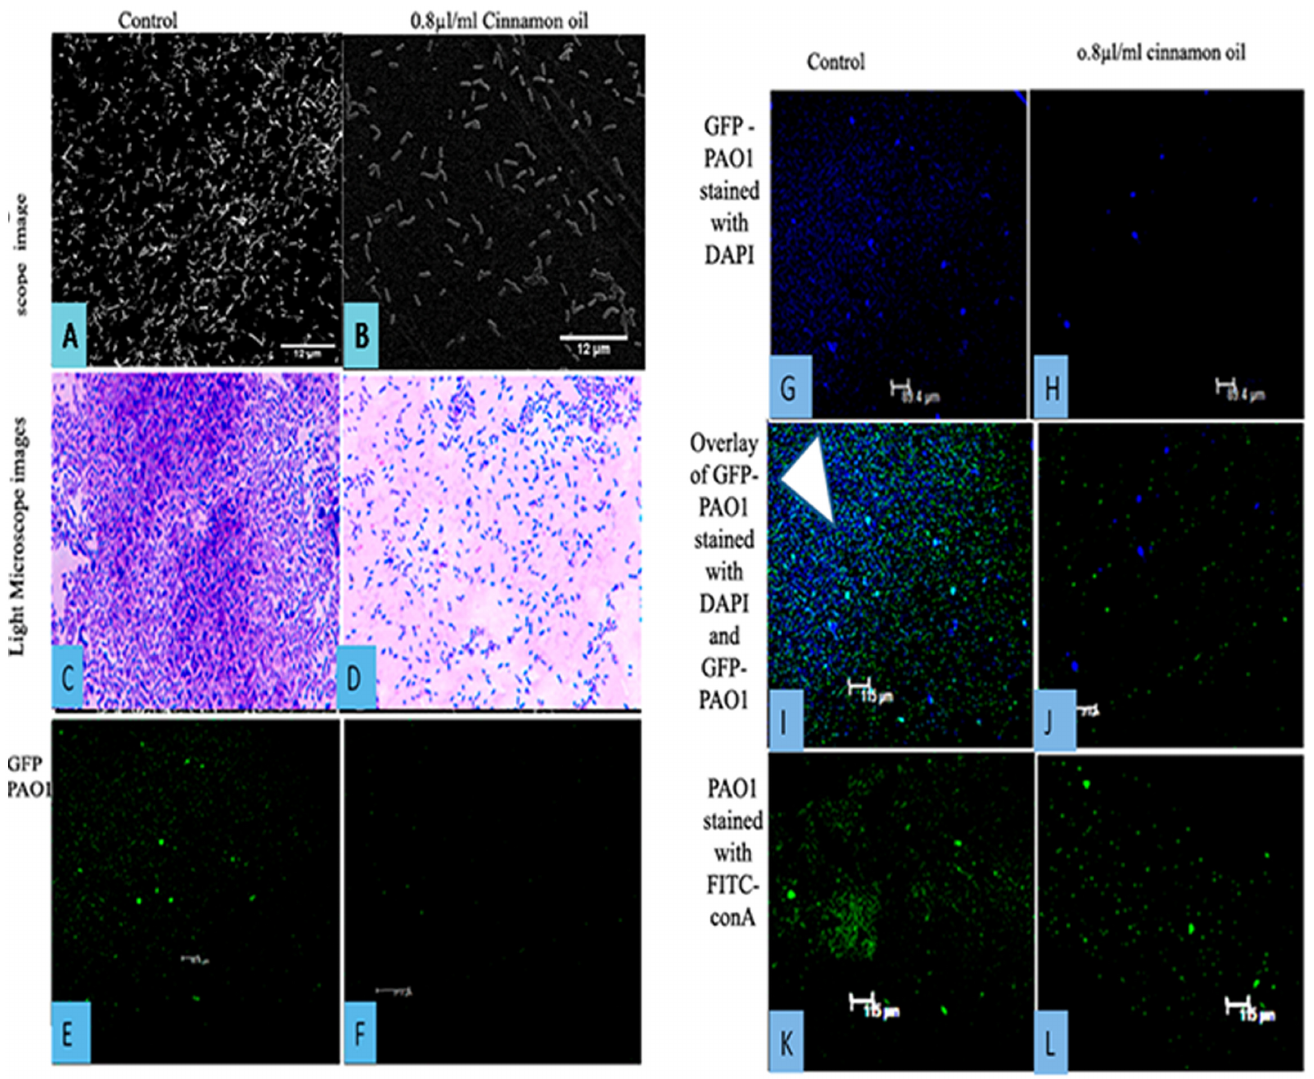
Fig 9. Microscopy images of P . aeruginosa PAO1 biofilms that formed with (right) 0.8 μ l/ml and without (left) cinnamon oil. Scanning electron microscopy (a-b) and light microscopy images (c-d). Inhibition of GFP-PAO1 biofilm formation (e-f). Significant reduction in the DNA content of the GFP-PAO1 biofilm (g-h). Overlay of (e-f, g-h) images displaying the reduction in extracellular DNA associated with the GFP-PAO1 biofilm (i-j). In the image (i), extracellular DNA is indicated with an arrowhead. A reduction in EPS production was observed after staining P . aeruginosa PAO1 with FITC-conA. This effect is evident from the scattered appearance of the cells in the treated samples